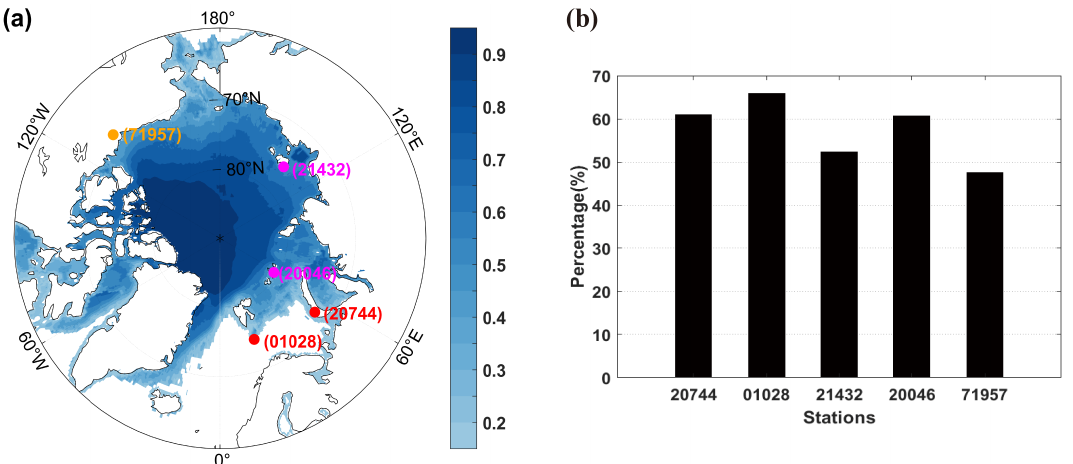
Figure 1. ( a ) Seasonal mean 2001–2017 autumn sea ice concentration and the selected five stations. The red dots denote open sea island stations (station 01028 and station 20744), the blue dots denote ice-covered island stations (station 20046 and station 21432), and the green dots denote the northern Canada coast station (station 71957); ( b ) the percentage of cyclone days in the total autumn days of the period 2001–2017 at each of the five stations.